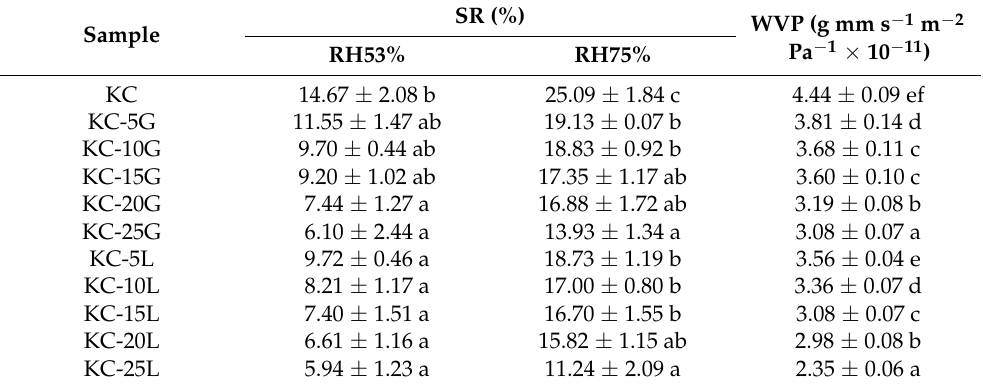
Table 2. SR and WVP of KC, KC-G and KC-L.